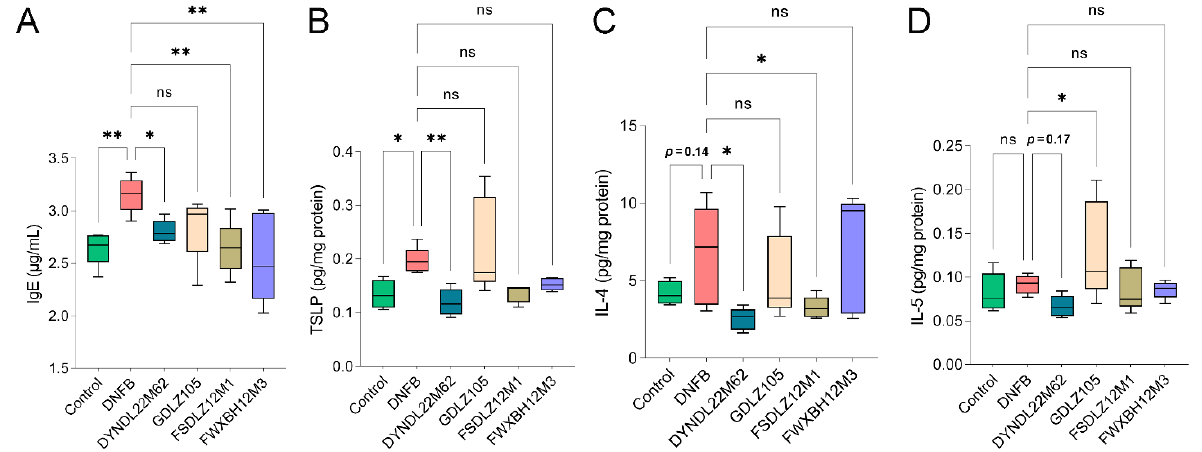
Figure 2. L. reuteri strains regulated IgE levels and the expressions of Th2 cytokines in AD-like mice. ( A ) IgE levels. ( B – D ) Changes in TSLP, IL-4, and IL-5 levels. * p < 0.05, ** p < 0.01 vs. DNFB group, ns, no significance. TSLP, thymic stromal lymphopoietin.